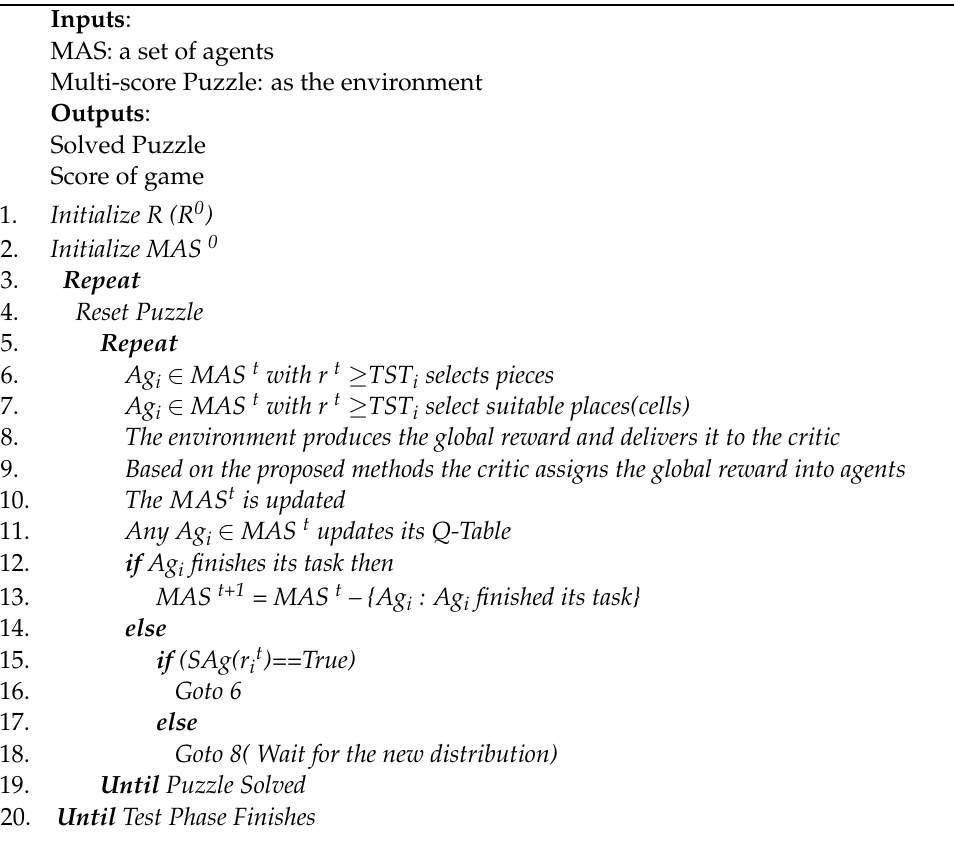
Algorithm 3: Algorithm